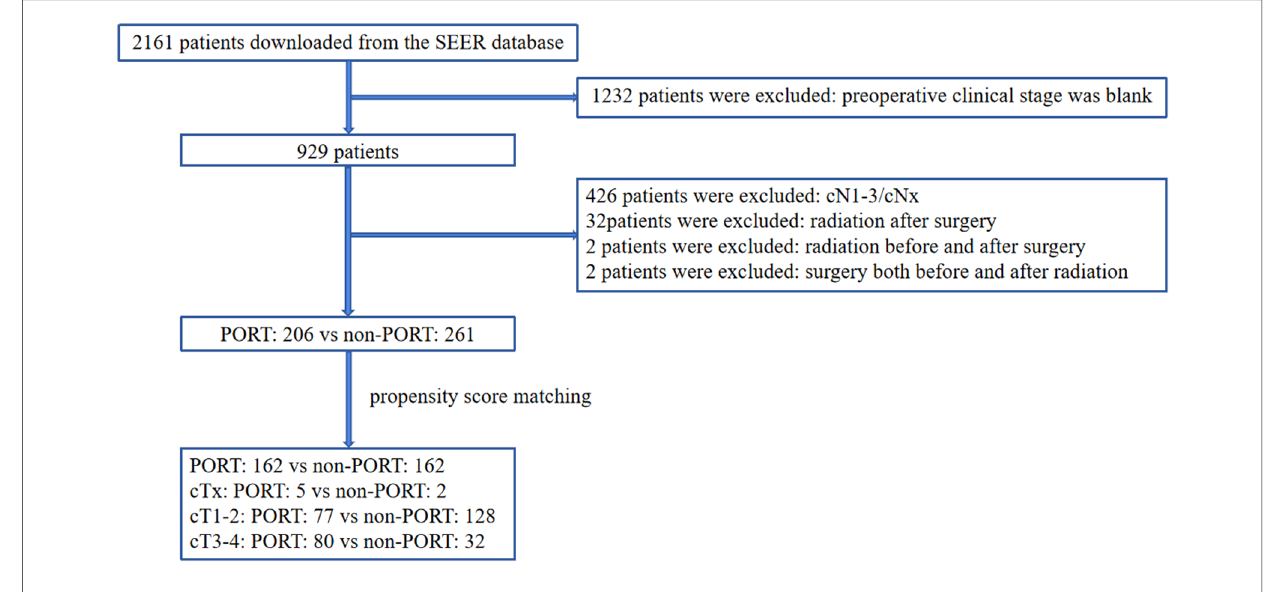
FIGURE 1 Flow chart of patient inclusion and exclusion.